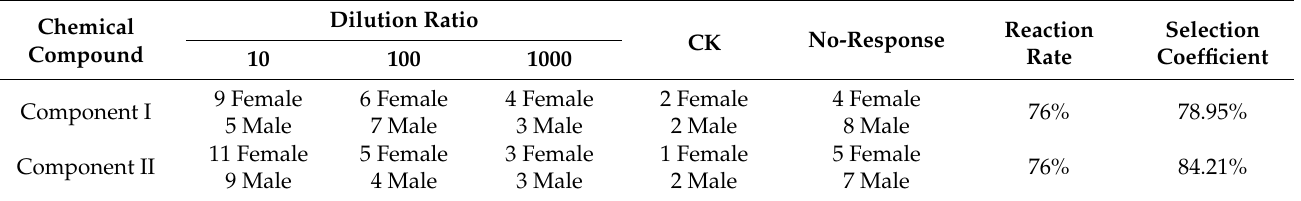
Table 2. Reactions of Monochamus saltuarius to different mixed components of host pine tree